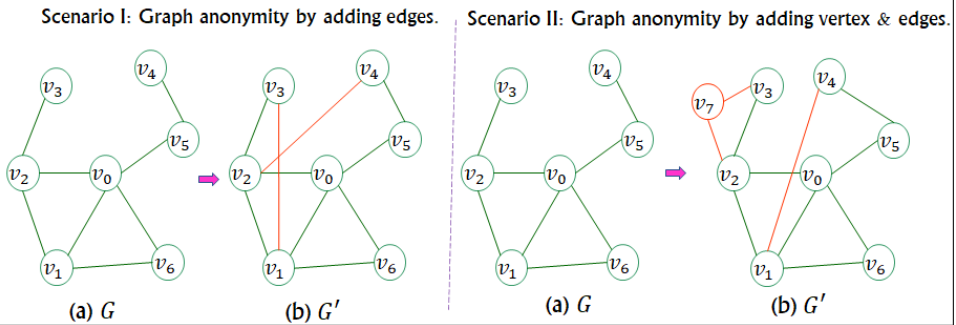
Figure 10. Overview of the G anonymization by adding edges and nodes and edges for PPGP.